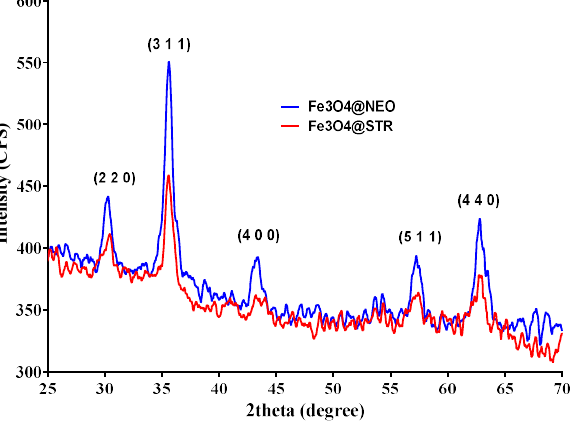
Figure 1. X-ray diffractogram of Fe 3 O 4 @STR and Fe 3 O 4 @NEO